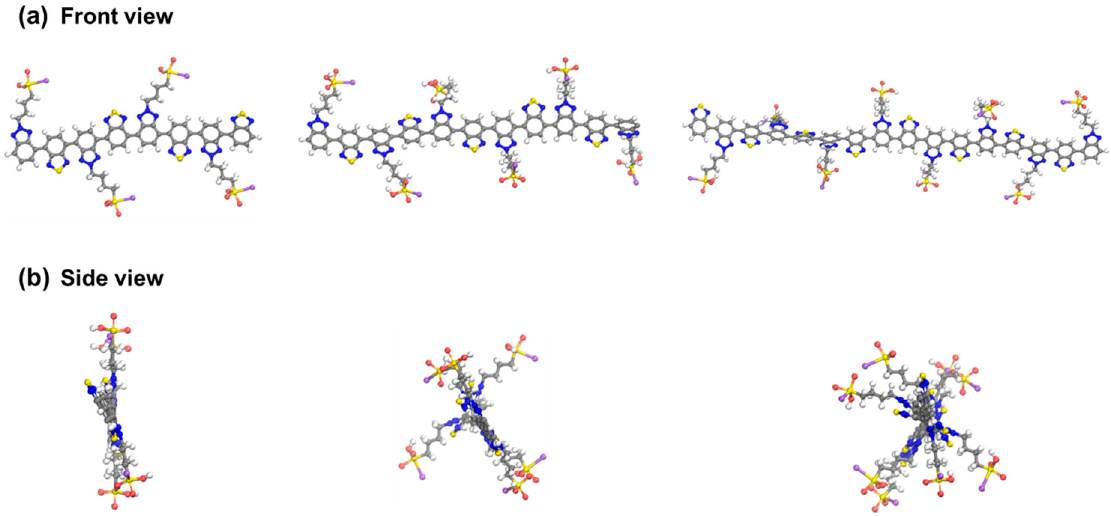
Figure 1. The front and side views of PBTBTz-SO 3 Na with the gradual increase of conjugated backbone length.